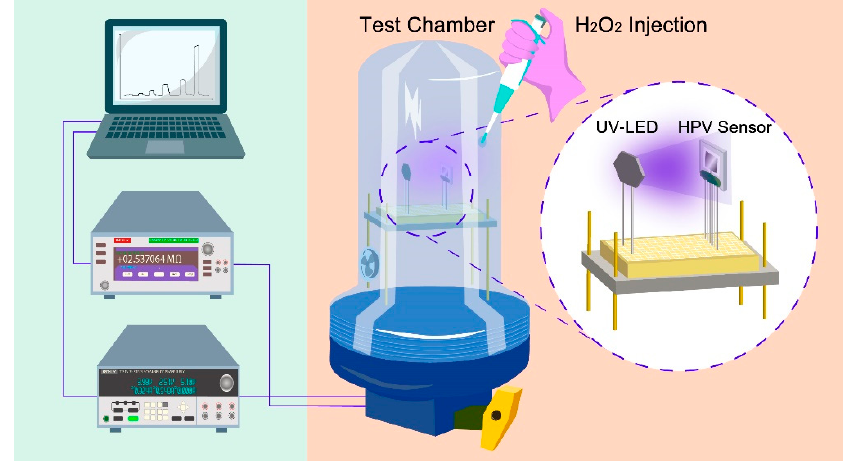
Figure 3. Schematic block diagram of the HPV testing system.